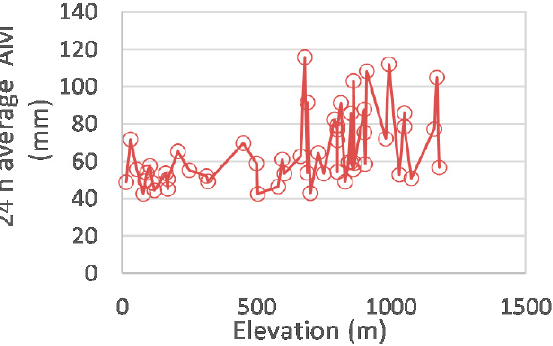
Table 1. Results from the BSS and BSSE models